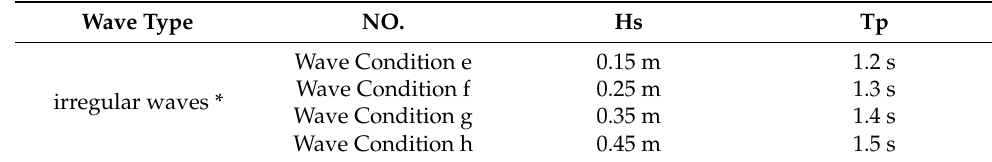
Table 2. The parameters of irregular waves.